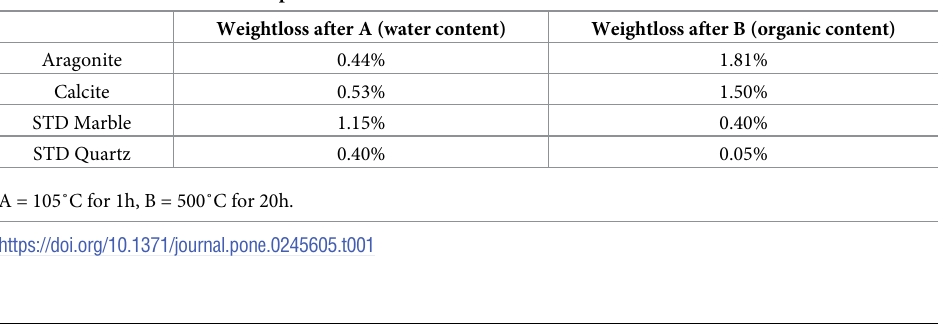
Table 1. Results of combustion experiments.